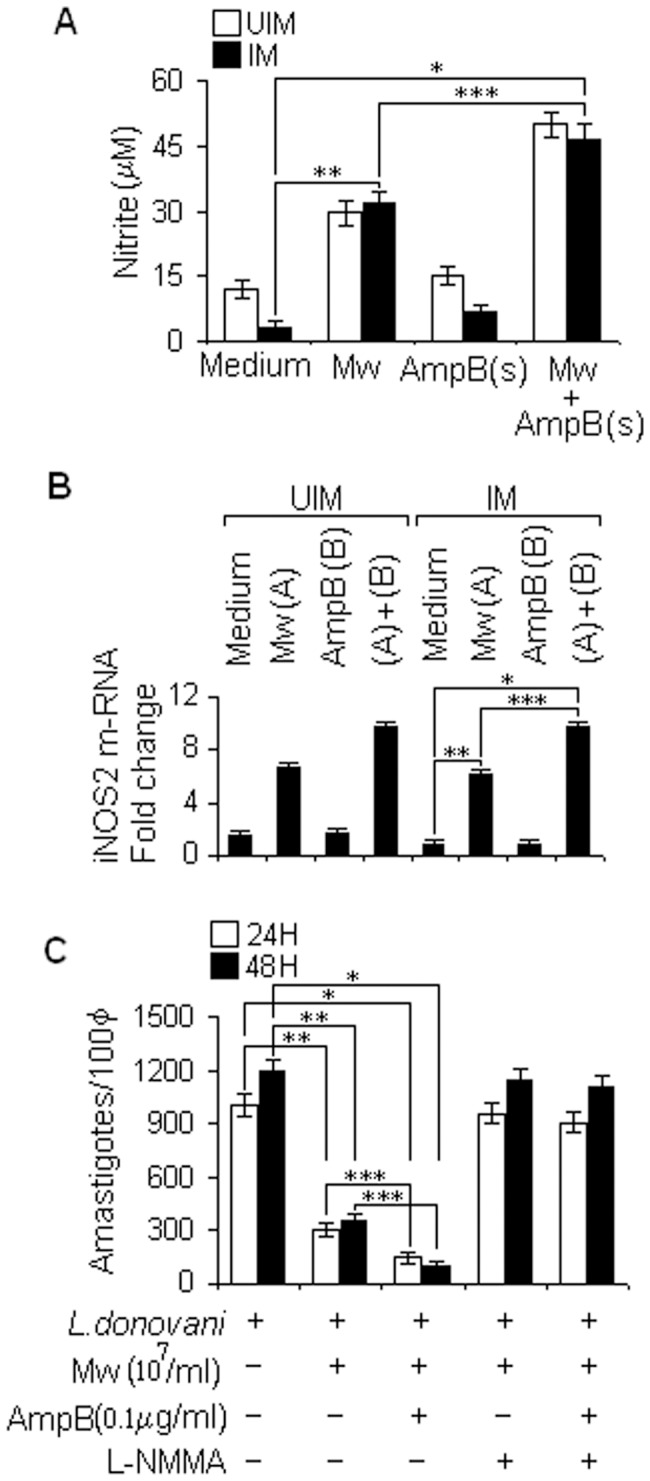

Mw induces the nitrite generation in Leishmania

donovani infected murine macrophages (A–C)(A) Uninfected (UIM) and infected (IM) macrophages were treated with Mw (107cells/ml), suboptimal dose of AmpB (0.1 µg/ml) and Mw plus AmpB (0.1 µg/ml). After 48 hours the cell free supernatant were collected and nitrate generation were measured in different sets. (B) mRNA expression of iNOS2 from similar experiments were determined by Real Time -PCR, (C) Macrophages cultured in chambered cover slides were treated with or without L-NMMA (0.4 mmol/L) for 1 h prior to infection followed by treatment with Mw and AmpB for 20 h and 44 h. After that, cover slips were stained with Giemsa and assessed for intracellular parasites number. L-NMMA significantly inhibited parasite killing activity of Mw and the similar type of inhibition was also observed in case of combination of Mw plus AmpB treatment. Results are presented as mean values. The experiment was repeated 3 times, yielding similar results and data were expressed as mean ± SD. *P<0.001, **P<0.01 compared with infected macrophages and ***P<0.05 compared with Mw treated macrophages; paired two-tailed Student’s t-test.